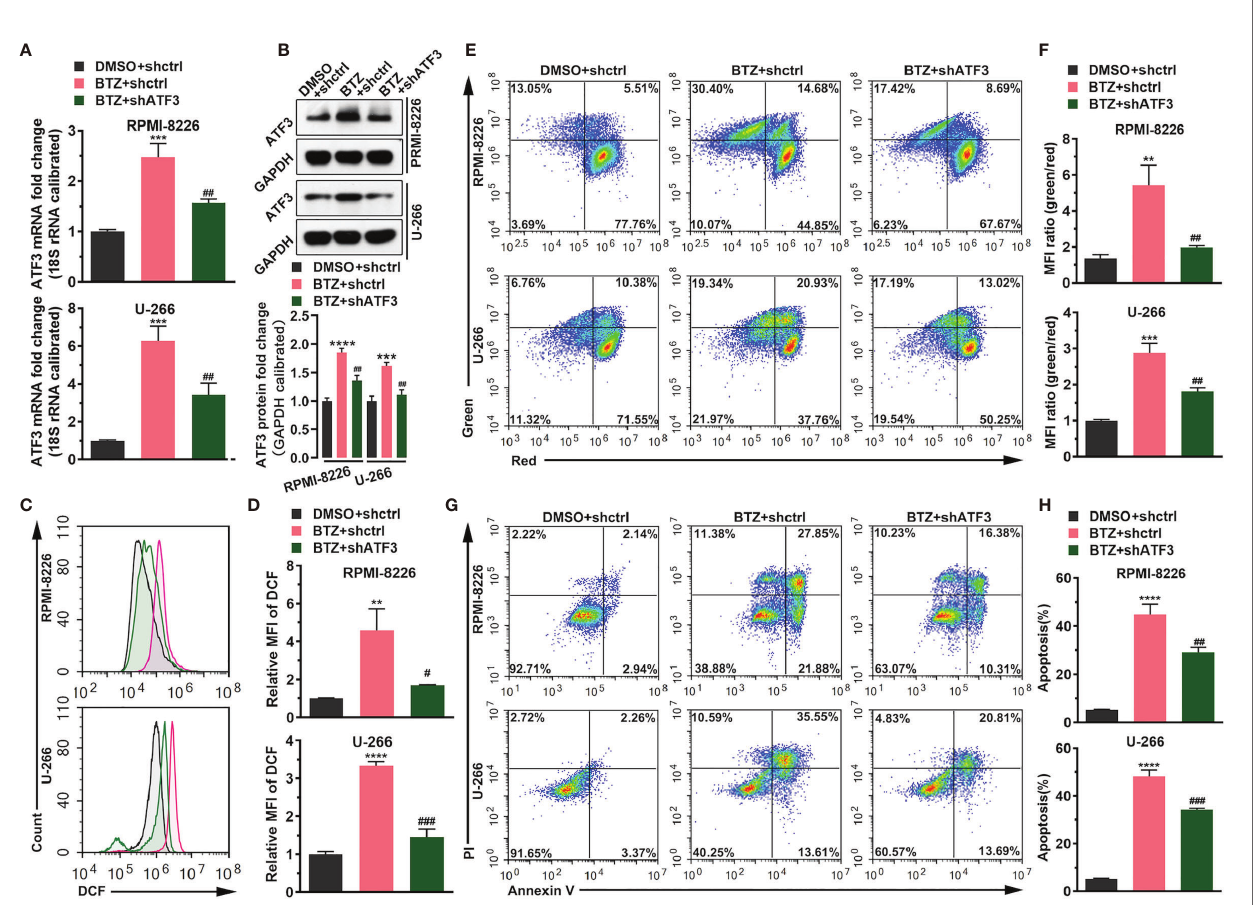
FIGURE 2 | BTZ modulates cell apoptosis via ATF3. Apoptosis was analyzed in three groups: (A) DMSO + shRNA ctrl; (B) bortezomib (BTZ) + shRNA ctrl; (C) BTZ + shATF3. (A) The ATF3 mRNA level was analyzed by RT-qPCR in RPMI-8226 and U-266 cells of the three groups. (B) The ATF3 protein level was analyzed in the three groups. Quanti fi cation of ATF3 band intensity, with values normalized to GAPDH. (C) The reactive oxygen species (ROS) level was measured by the Cellular ROS Assay Kit in the three groups. 2 ′ ,7 ′ -Dichloro fl uorescein (DCF) was detected by FACS. (D) Quantitation of the ROS level indicated by DCF. (E) The mitochondrial membrane potential (MMP) was analyzed by the JC-1 assay. (F) Quantitation of the MMP level indicated by the mean fl uorescence intensity (MFI). (G) Apoptosis was analyzed by annexin-V PI staining. (H) Quantitation of the percentage of apoptotic cells. Data were analyzed by one-way ANOVA, followed by Tukey ’ s post-hoc test. **P < 0.01, ***P < 0.001, and ****P < 0.0001 compared with the BTZ + shctrl group; # P < 0.05, ## P < 0.01, and, ### P value < 0.001 compared with the BTZ + shATF3